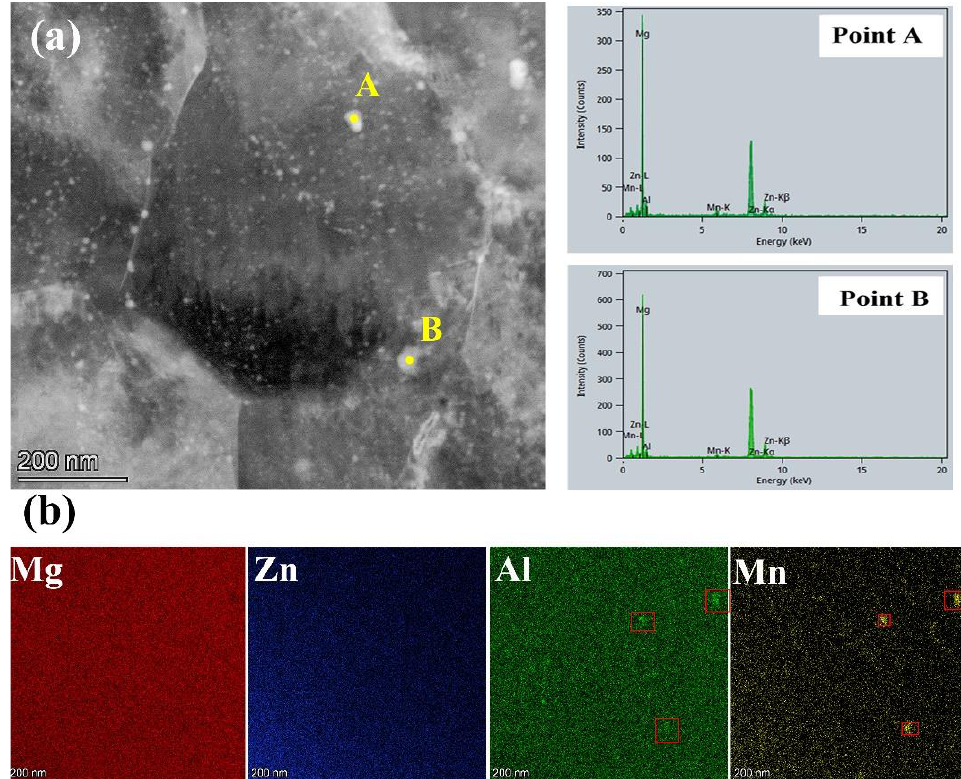
Figure 5. HAADF-STEM ( a ) and entire zone STEM-EDXS mapping ( b ) of as-RS AZ31 extruded rod.